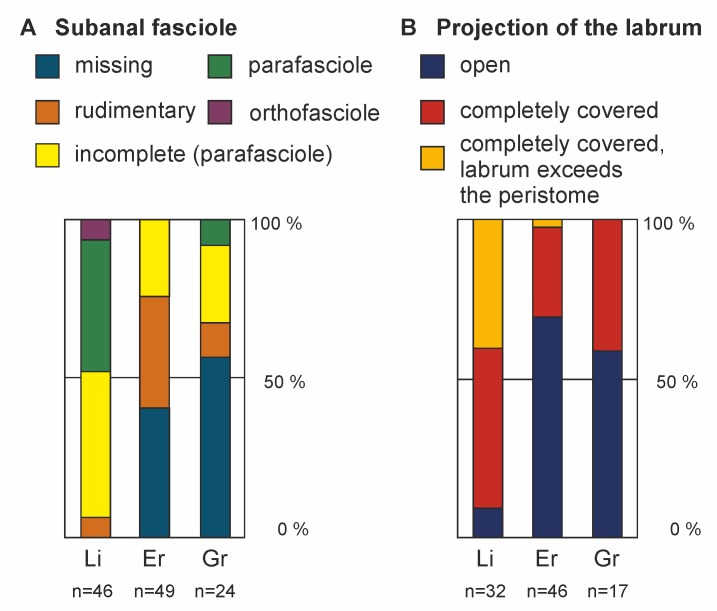
Variation in development of the subanal fasciole.Bar charts indicating the percentage for the particular populations in (A) the development of the subanal fascioles, (B) the development of the projection of the labrum (Li = Liencres area; Er = Erwitte area; Gr = Grimberg).